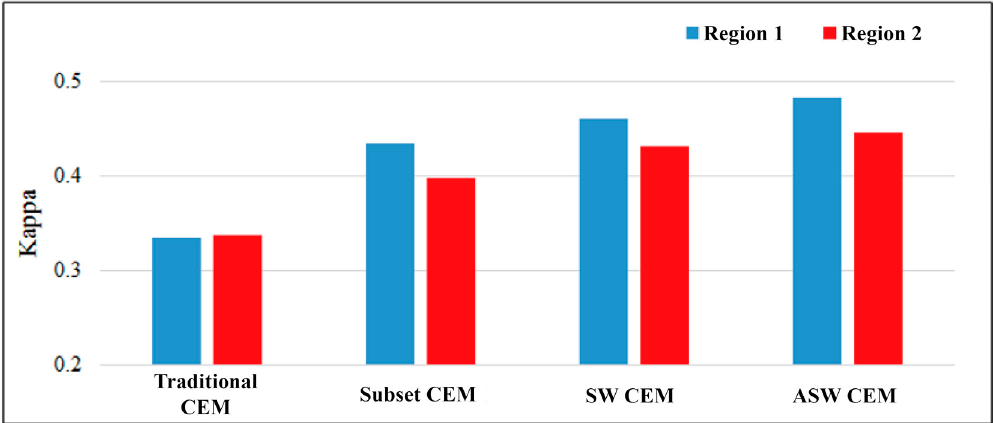
Figure 21. Kappa detection results of Region 1 and Region 2.